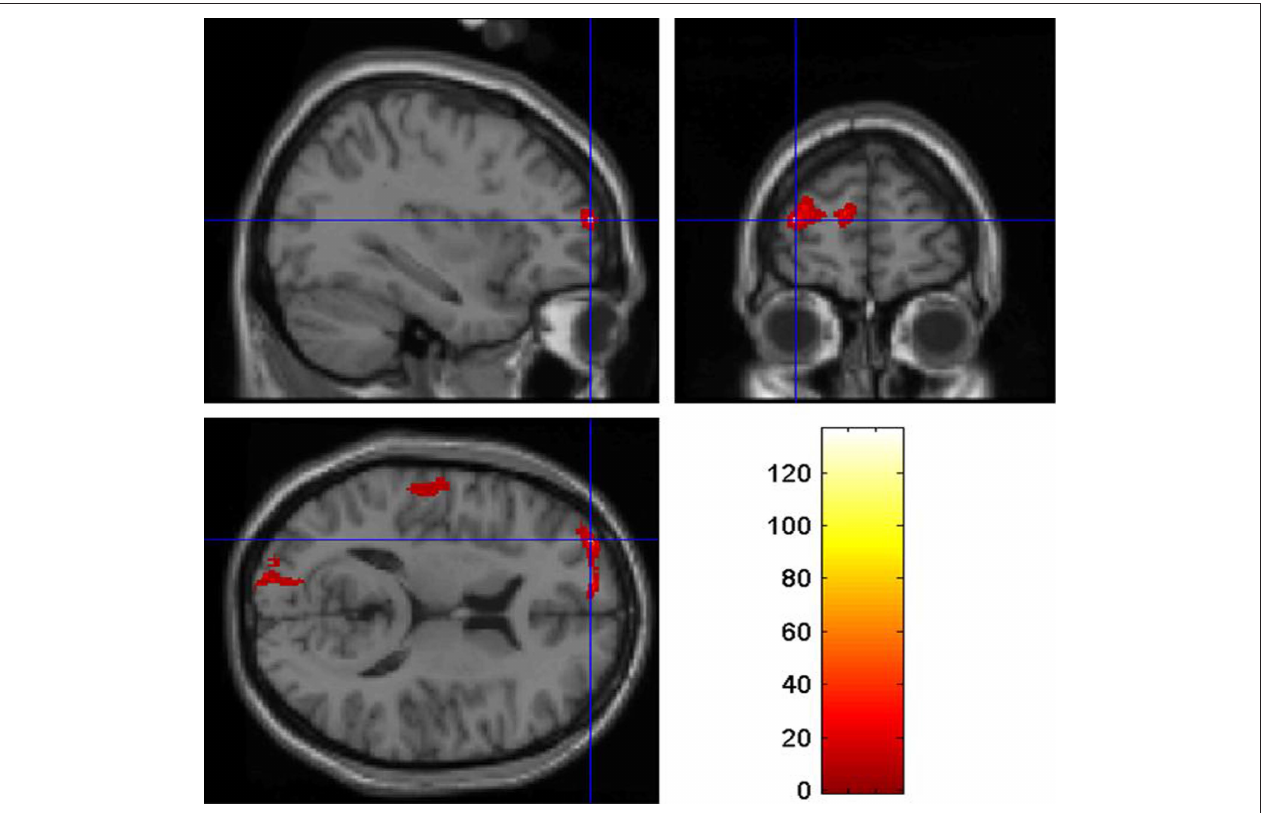
FIguRe 1 | Region of the left middle frontal gyrus showing reduced gray matter density in JF relative to healthy controls, at p < 0.05 (corrected for multiple